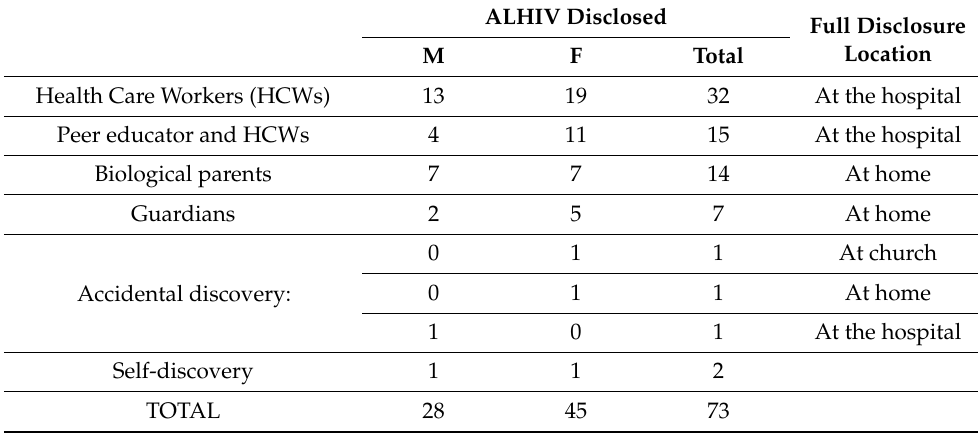
Table 2. Identity of the discloser and where disclosure took